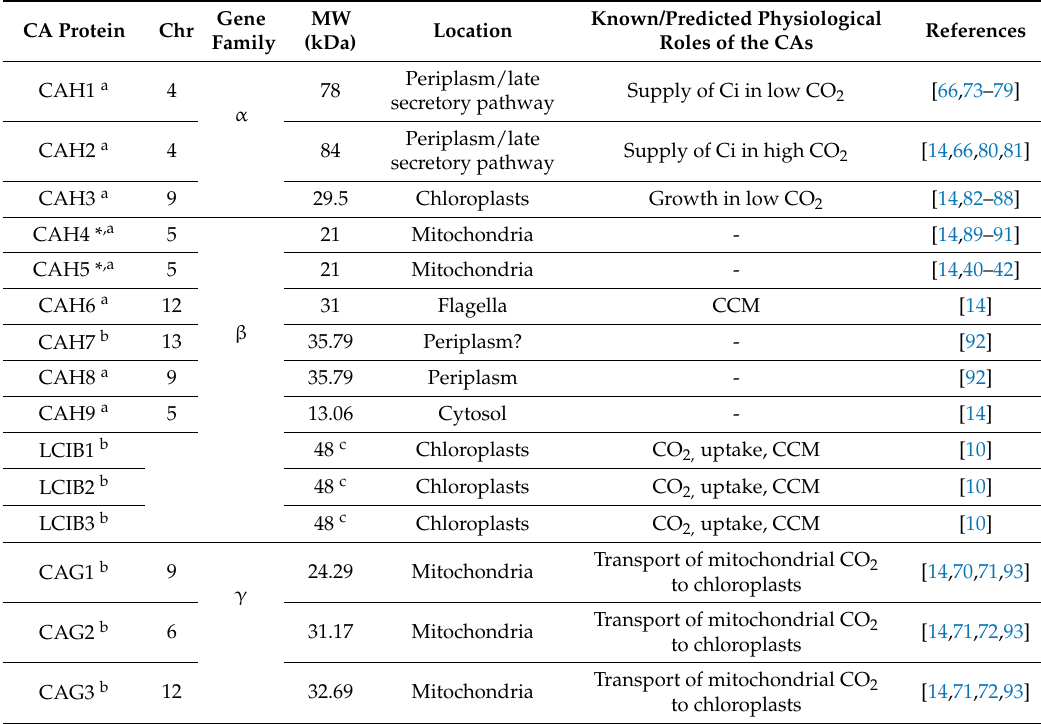
Table 2. Details of the 15 carbonic anhydrases found in Chlamydomonas reinhardtii belonging to the α , β , and γ gene